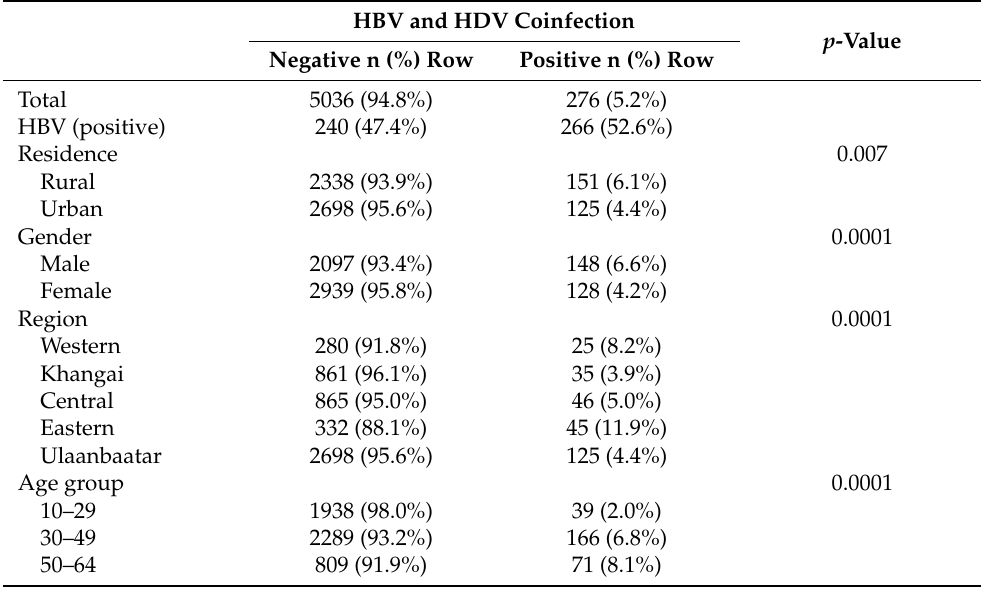
Table 2. Prevalence of HDV infections among population aged 10–64 years in Mongolia (n = 5312).